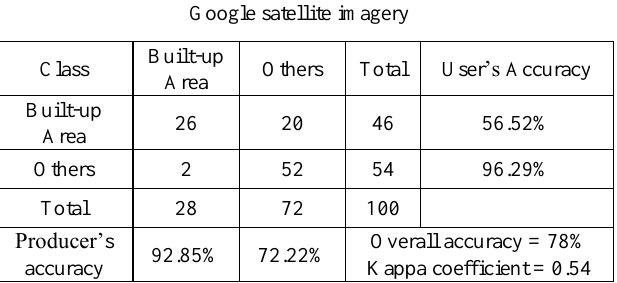
Table 1. Results of accuracy assessment (a) Confusion matrix before post extraction editing